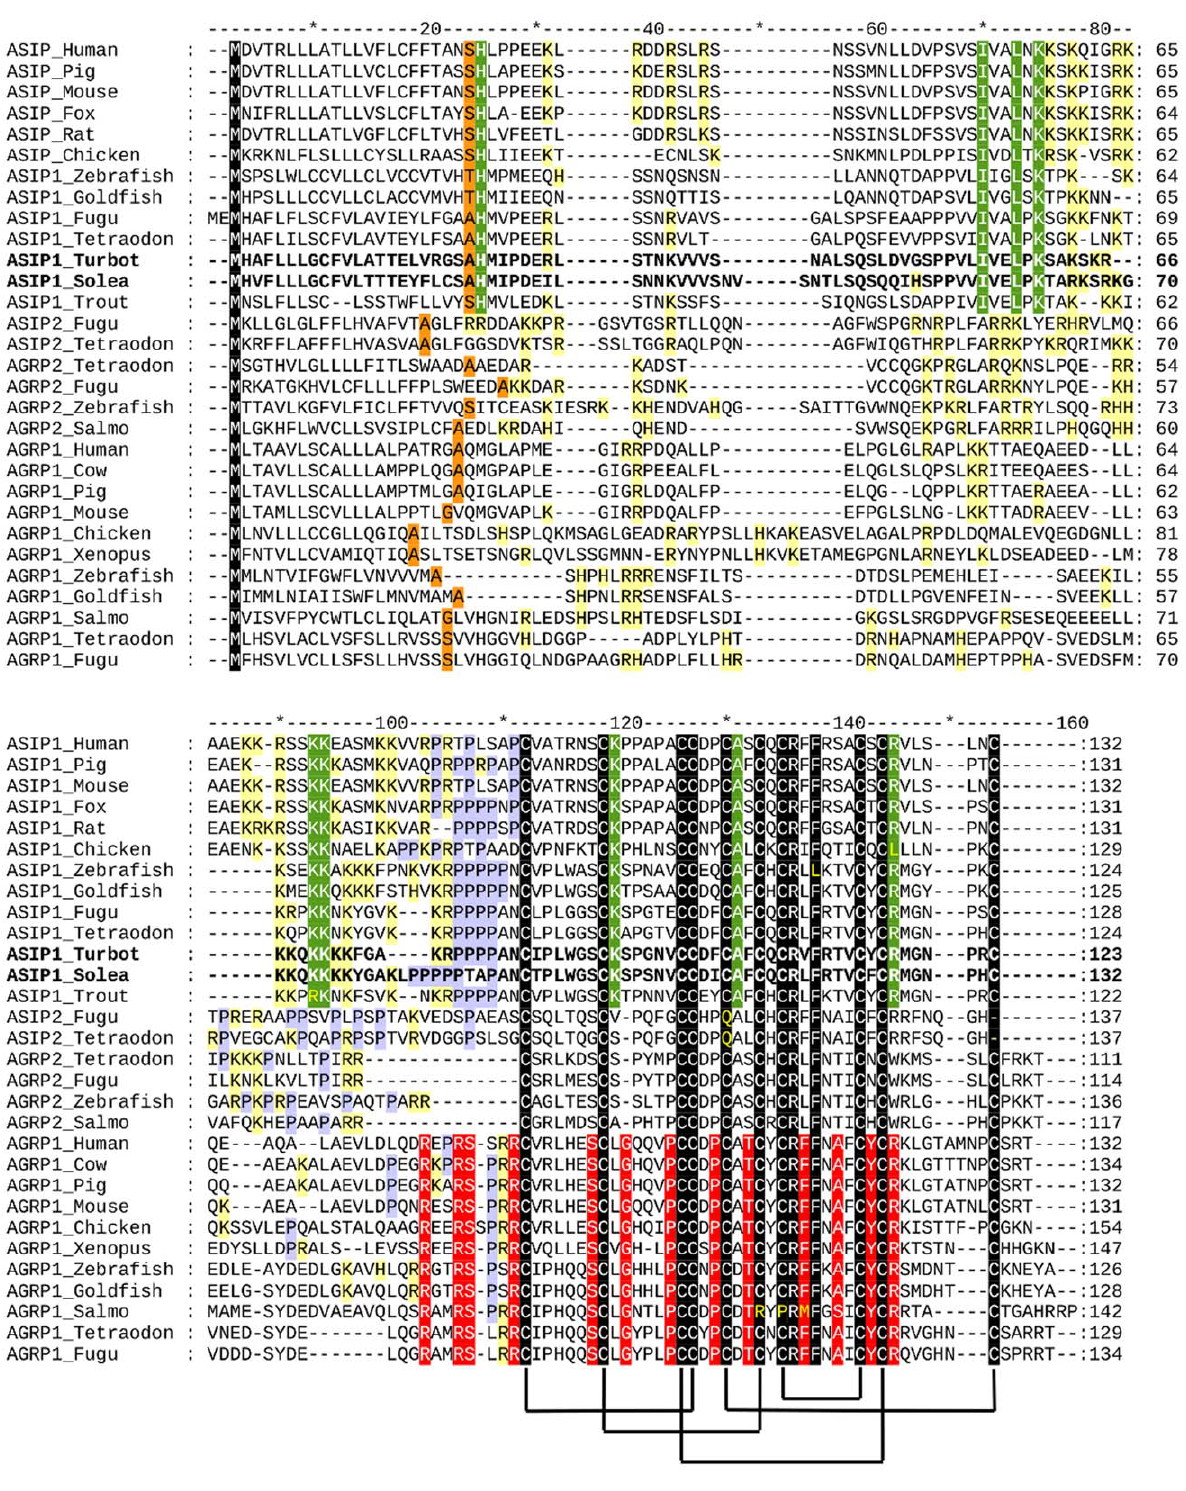
Figure 1. Alignment of agouti-signaling protein (asip) and agouti-related protein (agrp) amino acid sequences. Dashes were introduced to improve alignment. Orange boxes indicate the last residue of the predicted signal peptide. Black boxes show amino acid residues conserved in all sequences. Green boxes show residues only conserved in asip1 sequences. Red boxes indicate residues only conserved in agrp1 sequences. Yellow boxes indicate basic residues before cysteine domain. Blue boxes show residues of the short tail present in all agrp sequences. Purple boxes indicate putative glycosilation sites. Lines joining cysteine residues indicate putative disulfide bonds forming the cysteine domain. Arrow shows conserved motif for agrp post-transcriptional processing.